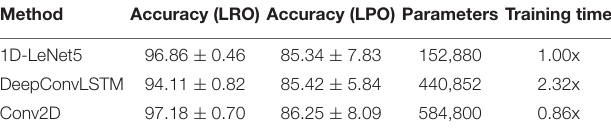
TABLE 2 | Comparison results for the general 20 body postures and gestures dictionary (in %) with various